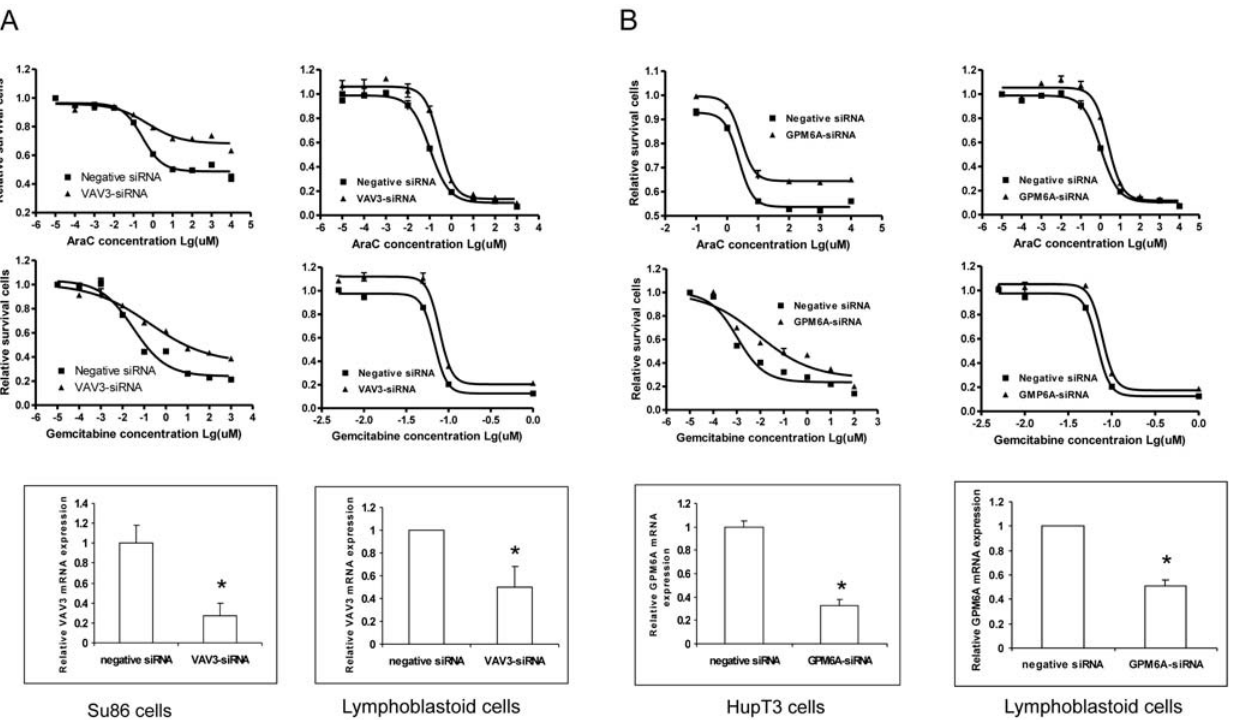
Figure 5. Functional characterization of candidate genes with siRNA knock down of VAV3 (A) and GPM6A (B). Knock down of VAV3 and GPM6A expression in human SU86 and Hup-T3 pancreatic cancer cell lines as well as lymphoblastoid cell lines showed increased resistance to gemcitabine and AraC after siRNA knock down as determined by MTS assays. Error bars represent SEM values for 3 independent experiments. Quantitative RT-PCR was performed to assess VAV3 and GPM6A gene expression levels after knock down with specific siRNAs. Results are expressed as % of control. Error bars represent SEM values for 3 independent experiments. * =p , 0.05.